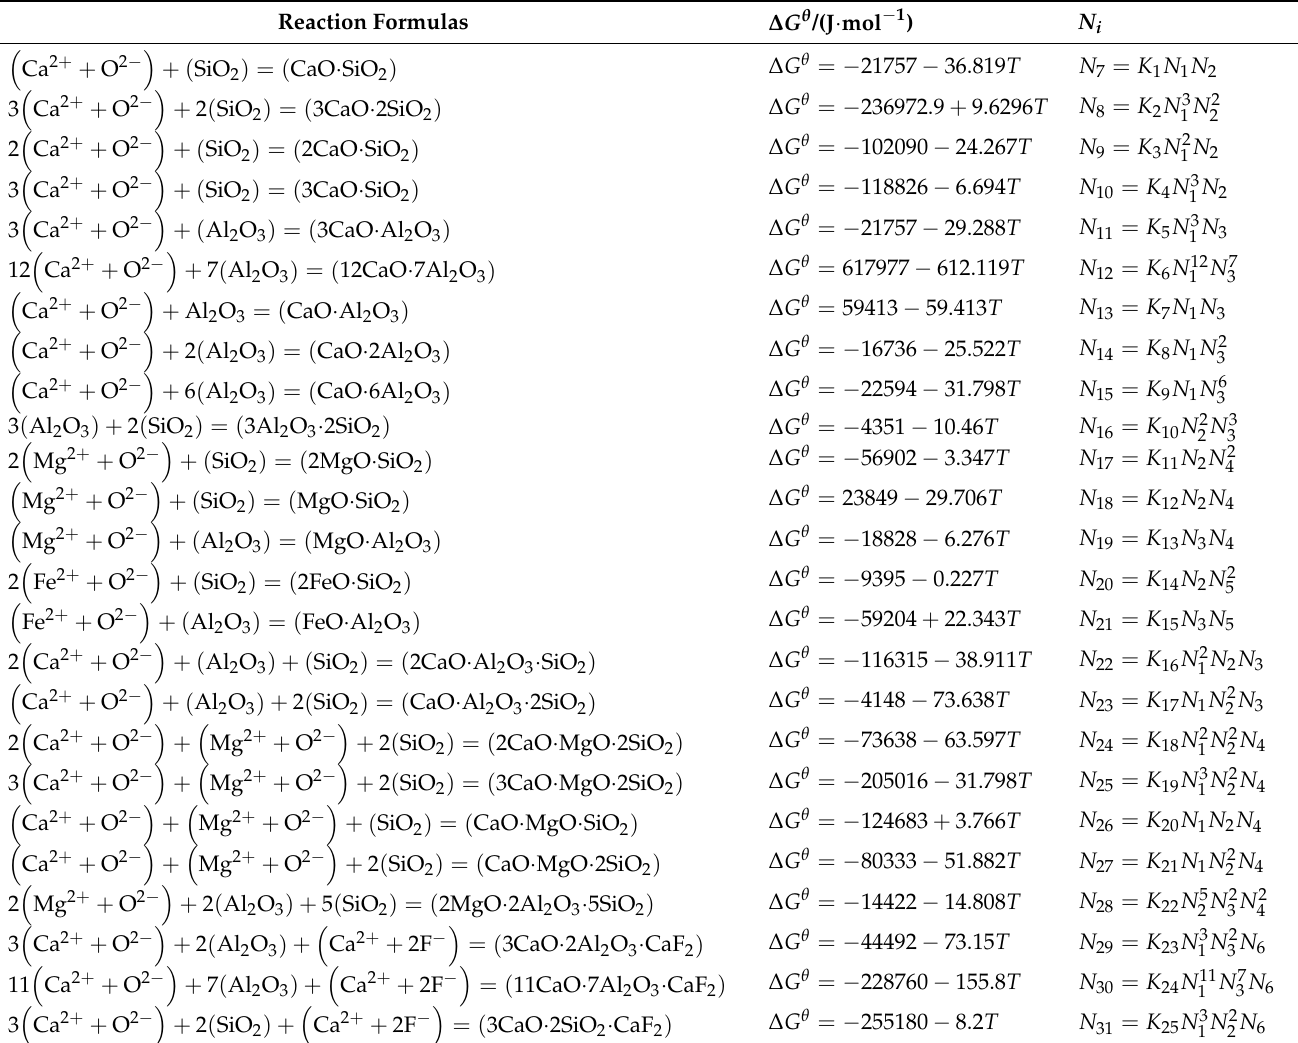
Table 4. Chemical reaction formulas of complex molecules, Gibbs free energy and mass action concentrations of the slag system